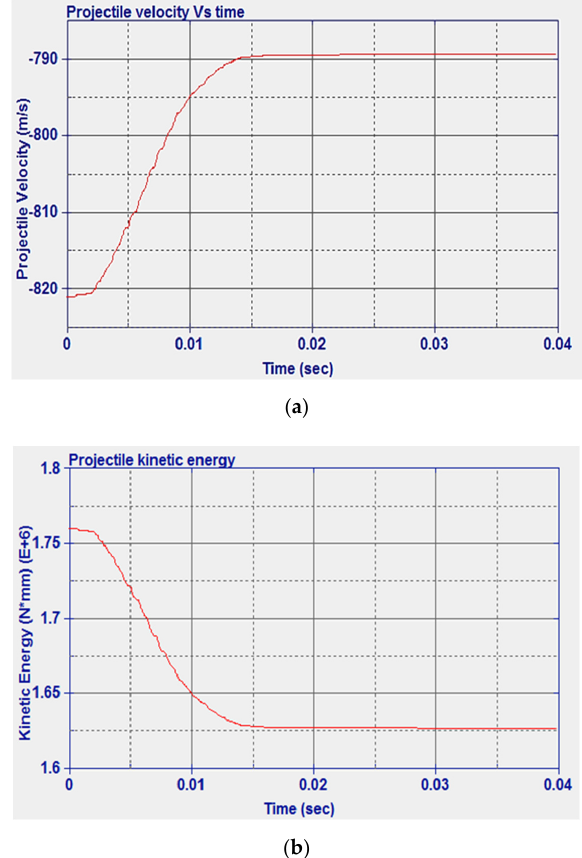
Figure 7. Steel solid plate: ( a ) Projectile velocity vs. time, ( b ) kinetic energy vs.